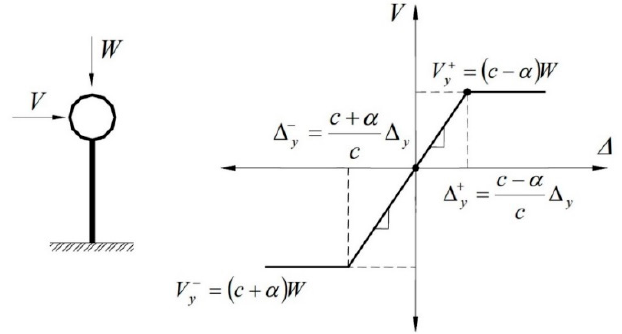
Figure 5. Single degree of freedom (SDOF) system without tilting and with asymmetric yielding.